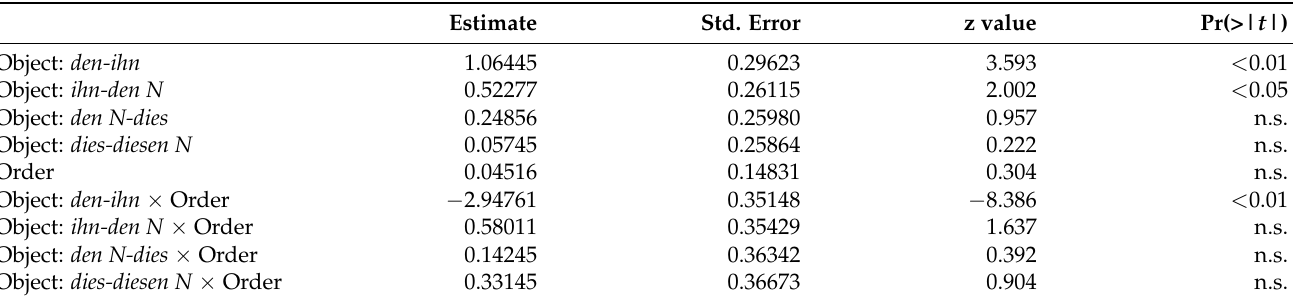
Figure 1. Mean acceptability in Experiment 1. Error bars show 95% confidence intervals. Table 2. Ordinal mixed model for Experiment